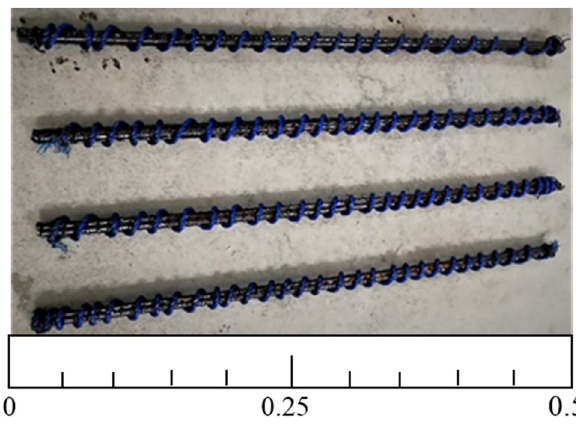
Figure 4: Polypropylene fi ber wrapped around steel bar ( scale in meters ) .